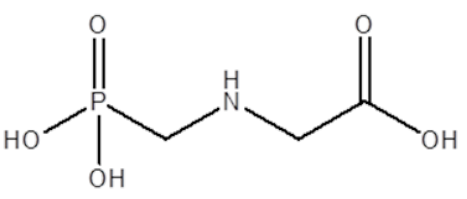
Figure 1. Chemical structure of